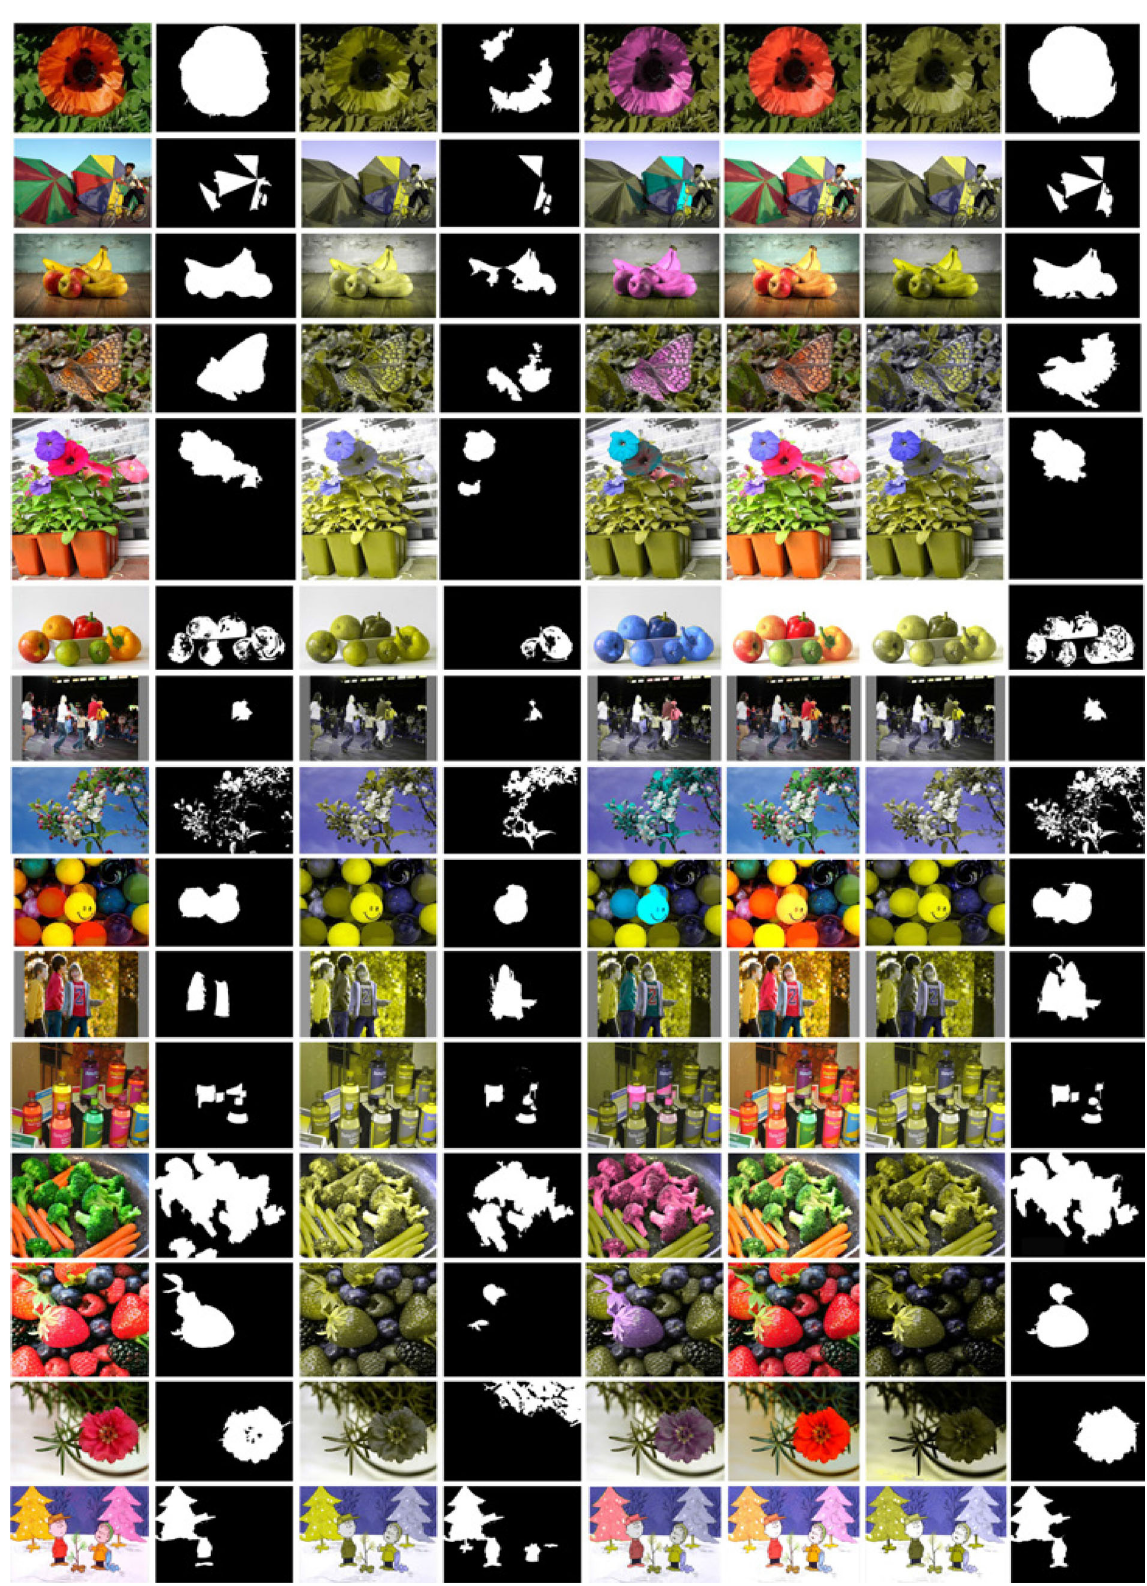
Fig. 7 Some examples of saliency-driven image correction for deuteranopia